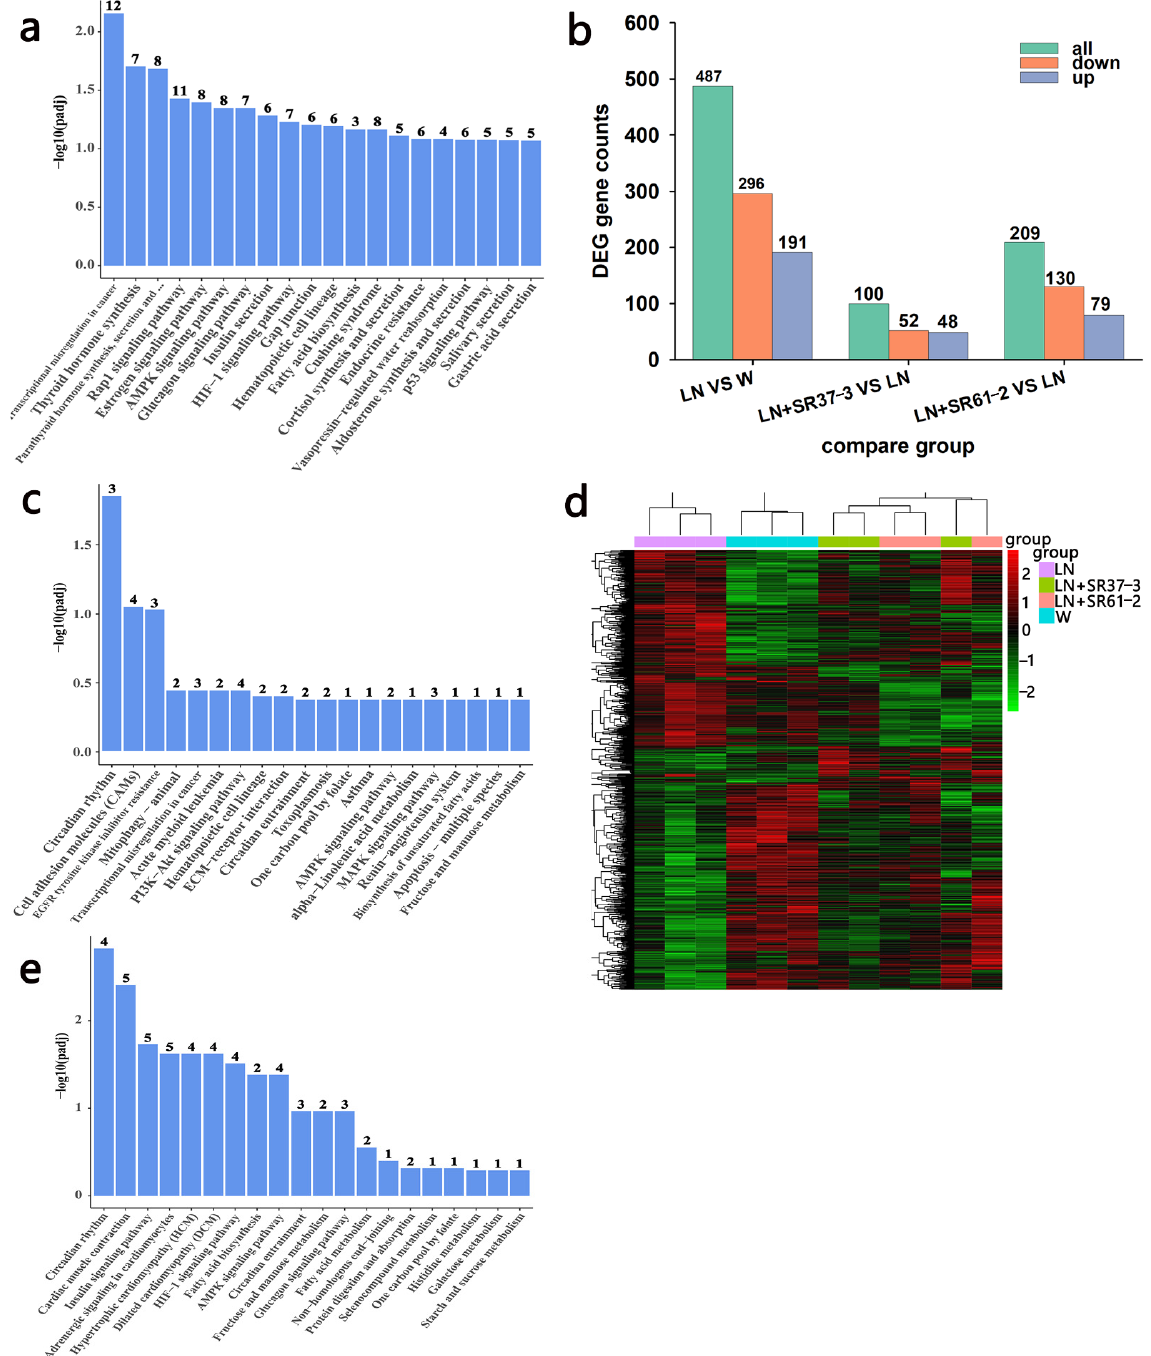
Figure 6. The functional enrichment and expression profile of DEGs in the thoracic aorta. ( a ) The KEGG PATHWAY functional enrichment of down-regulated DEGs between the disease group and the control group. ( b ) The bar chart shows all significant DEGs in each comparison group, including up- regulated or down-regulated genes. ( c ) The KEGG PATHWAY functional enrichment of up-regulated DEGs between the LN + SR31-3 group and the LN group. ( d ) Heatmap showing the differentially expressed lncRNAs between different groups. ( e ) KEGG PATHWAY functional enrichment of up- regulated DEGs between the LN + SR61-2 group and the LN group. cont W: animals not treated